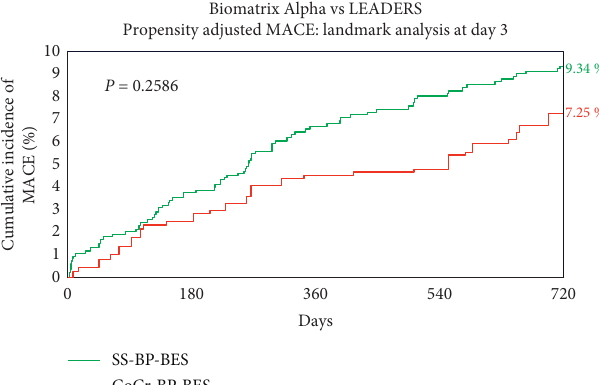
Figure 4: Propensity-adjusted MACE at 2 years with a landmark at day 3. CoCr-BP-BES � cobalt-chromium biodegradable polymer Biolimus A9-eluting stent, MACE � major cardiac adverse events, SS-BP-BES � stainless steel biodegradable polymer Biolimus A9-eluting stent.